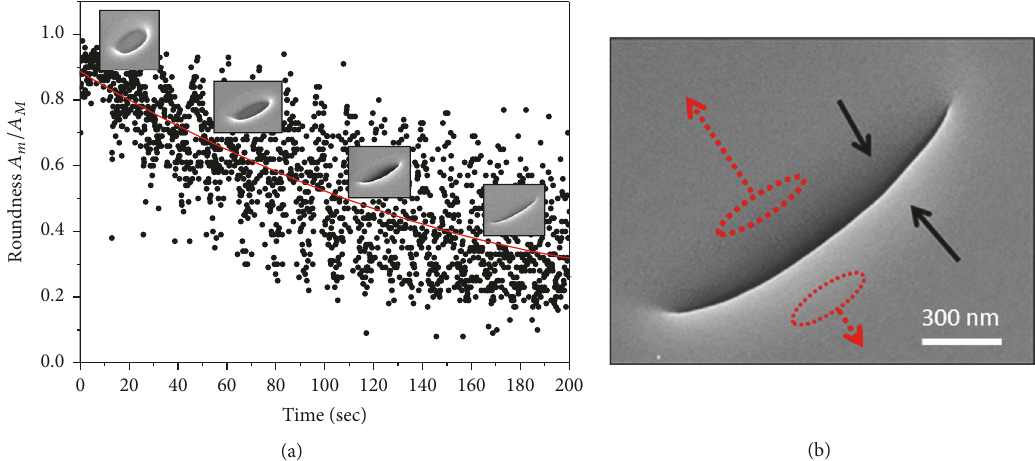
Figure2:(a)Time-resolvedroundnessvaluesformicrowellsduringlaserirradiation(blackdots:roundnessofindividualwells,redline:mean roundness). In the insets, representative SEM images taken with sample tilted by 45 ∘ of four different time steps. (b) SEM image (sample tilted by 45 ∘ ) of a single microwell after irradiation (black arrows: the direction of the pore reduction and red arrows: direction of the mass migration of the